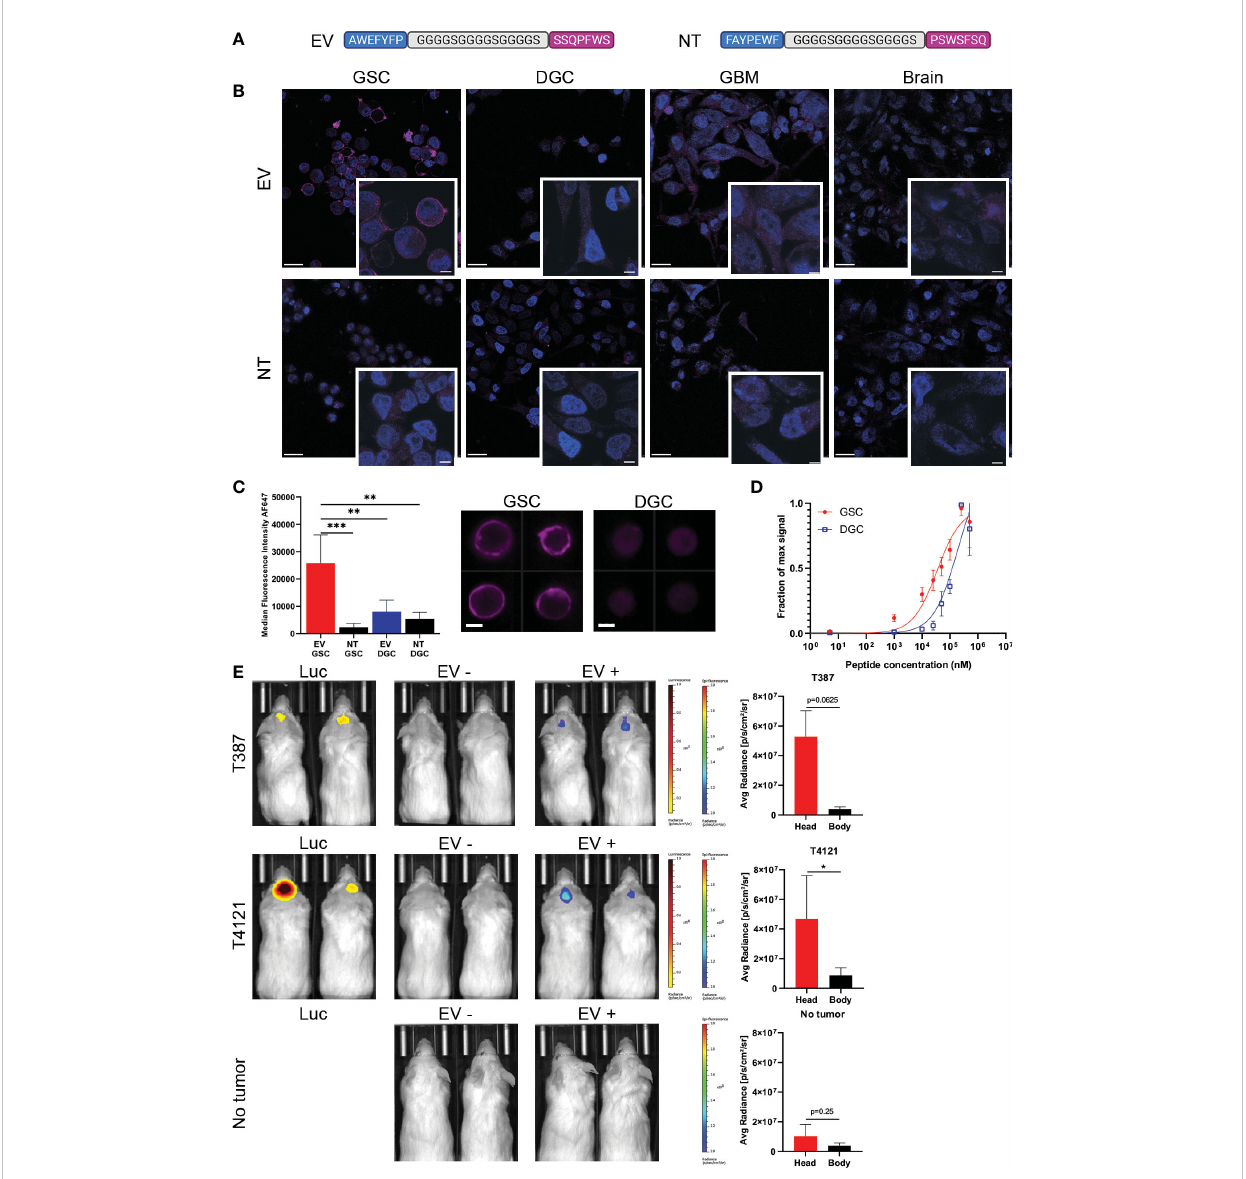
FIGURE 2 Speci fi city of the peptide for GSCs. (A) The two peptides recovered with phage display biopanning have been combined as a dual peptide (EV), linked by a sequence of glycine and serine. A non-targeting peptide (NT) employed the same amino acids in a scrambled sequence. (B) Immunocyto- fl uorescent staining of different cells with EV or NT peptides (purple staining). Nuclei are stained with DAPI (blue staining). Scale bars: 20 m m, in zoomed images: 5 m m. (C) ImageStream quanti fi cation and representative images of EV staining on GSCs (red) and DGCs (blue), compared to NT (black bars), ** = p < 0.01, *** = p < 0.001. Signal intensity represented is actual measured median fl uorescence intensity. Data in quadruplicate. Scale bars: 10 m m. (D) Measure of the binding af fi nity of GSCs (red) or DGCs (blue) with increasing concentration of EV peptide by fl ow cytometry. Data in quadruplicate. (E) Representative images of mice and fl uorescence measurements acquired with the IVIS Lumina. The presence of tumor was con fi rmed by luminescence after Luciferin injection. Images were acquired before (EV-) and after (EV+) EV injection for the T387 cells (top row), T4121 cells (middle row), and sham implanted (bottom row). The body measurements were taken at the lower back of the mice. The fl uorescence scale remained the same for all the mice, and the luminescence scale was adapted between T387 and T4121 tumors, * = p <